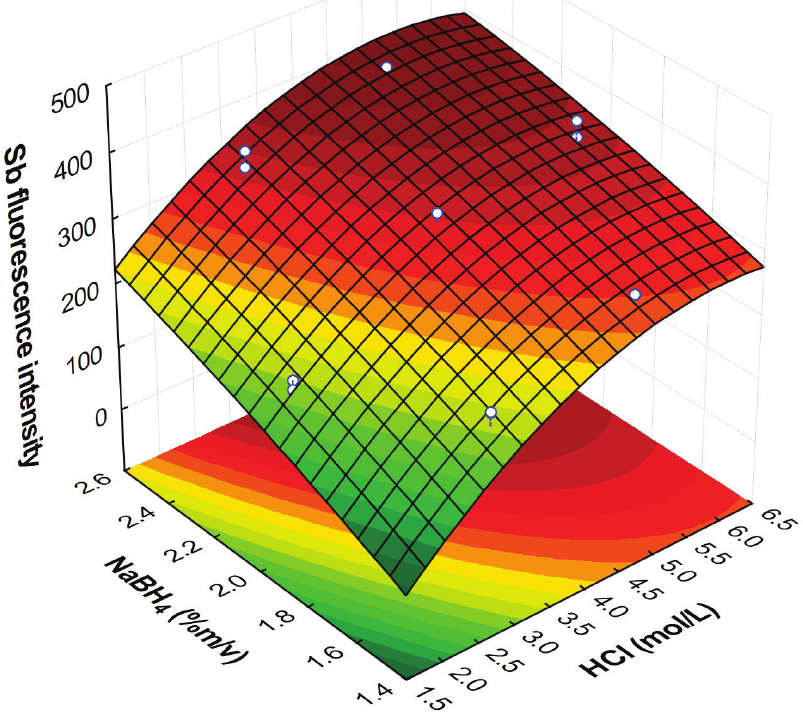
Figure 2 - Response surfaces for quadratic function adjusted to the data obtained from application of the Doehlert design in the optimization of stibnite